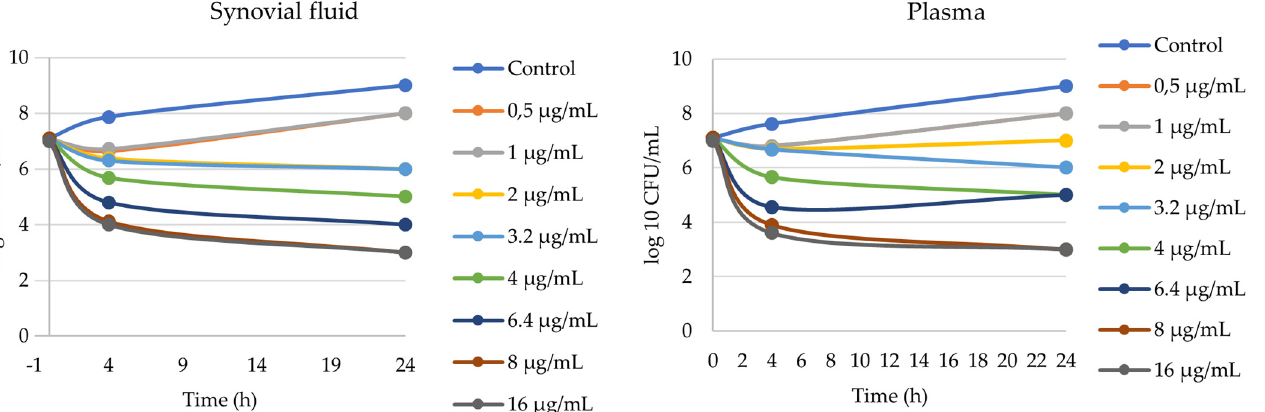
Figure 3. In vitro killing–time curves of fl orfenicol against S. suis 96 strain in three di ff erent media (synovial fl uid, plasma, CA-MHB). Table 2. PK/PD breakpoints determined from the sigmoidal E max inhibition equation in porcine syn- ovial Fluid, plasma and CA-MHB. Parameters -* Emax = maximum (response) killing capacity, EC50 = in vitro concentration of fl orfenicol capable of half the maximum killing capacity expressed in hours, E0 = initial bacterial viable cell count, Gamma = Hill coe ffi cient (slope of the curve).*Florfenicol did not reach this level even at the highest concen- tration (16 µg/mL).